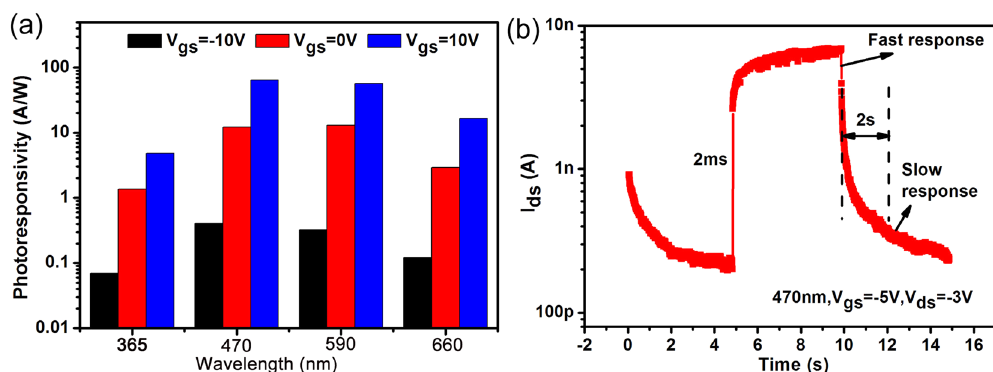
Figure 4. ( a ) The photoresponsivity under different light wavelengths (typically for 365 nm, 470 nm, 590 nm, 660 nm) with V gs changing from − 10 V to + 10 V. ( b ) Time-resolved photoresponse of the heterojunction under 470 nm light illumination, recorded for V gs = − 5 V, V ds = − 3